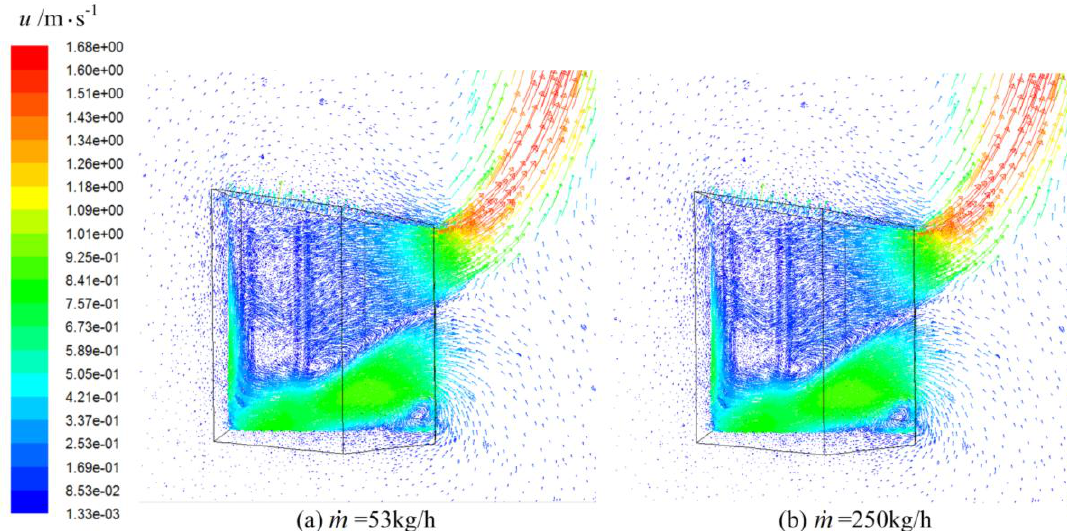
Figure 15. Air velocity field in the central vertical section of the